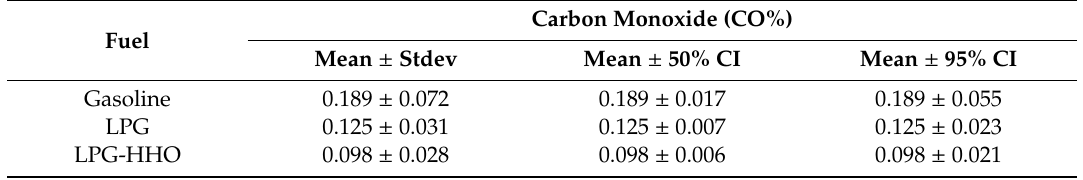
Table 3. 50% and 95% confidence intervals for mean CO emissions.